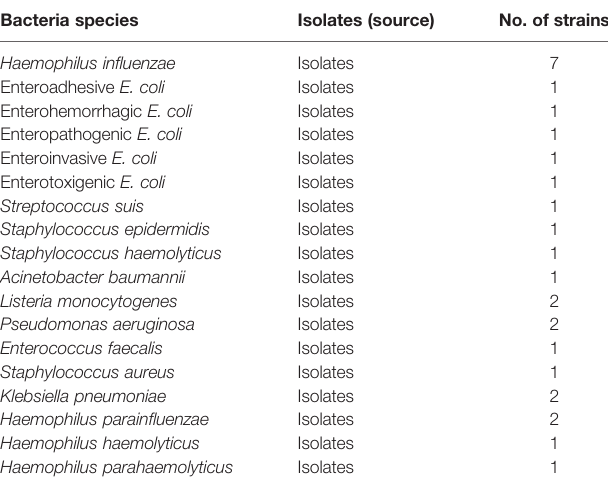
TABLE 1 | Bacterial strains used in this